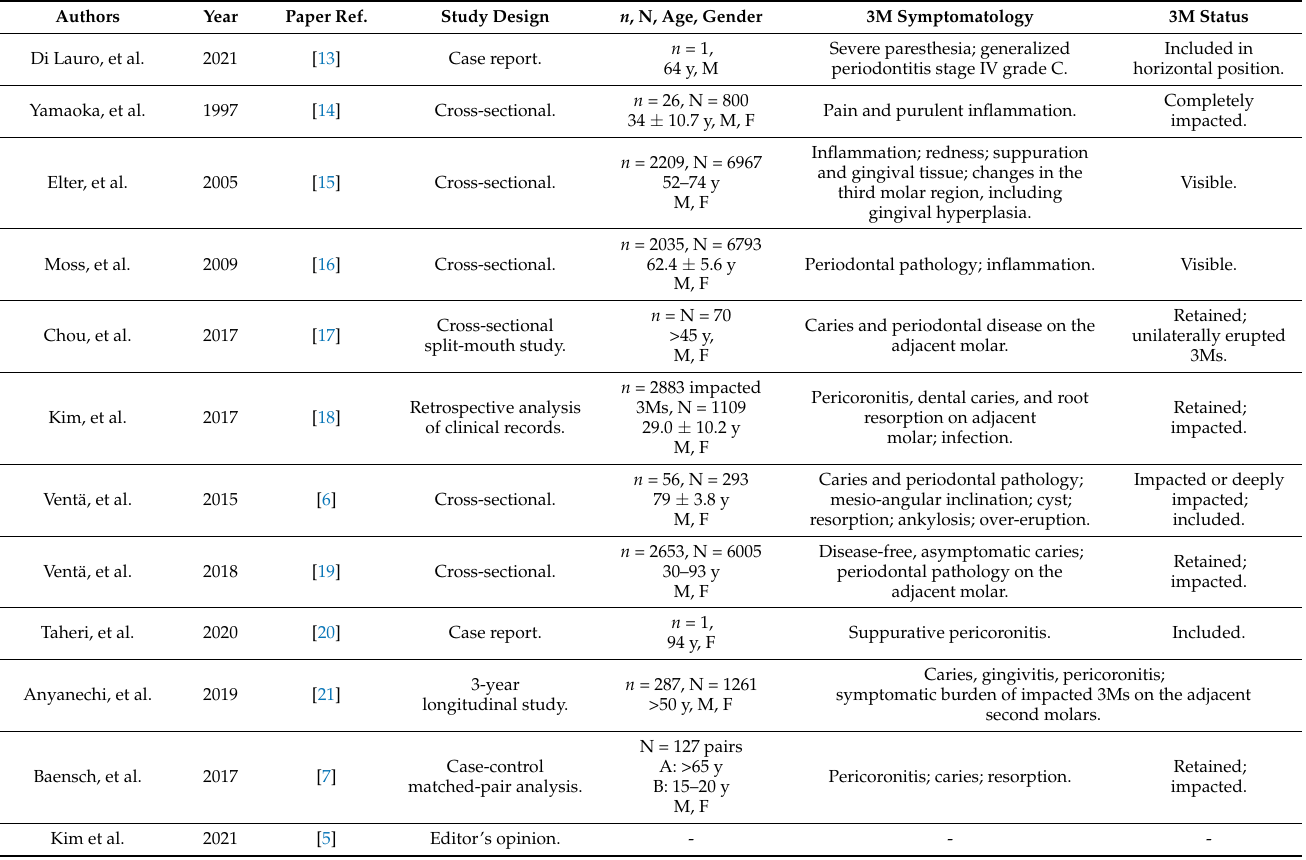
Table 1. Studies on the clinical symptomatology and complications associated with the third molar in the elderly (order of relevance to the present case